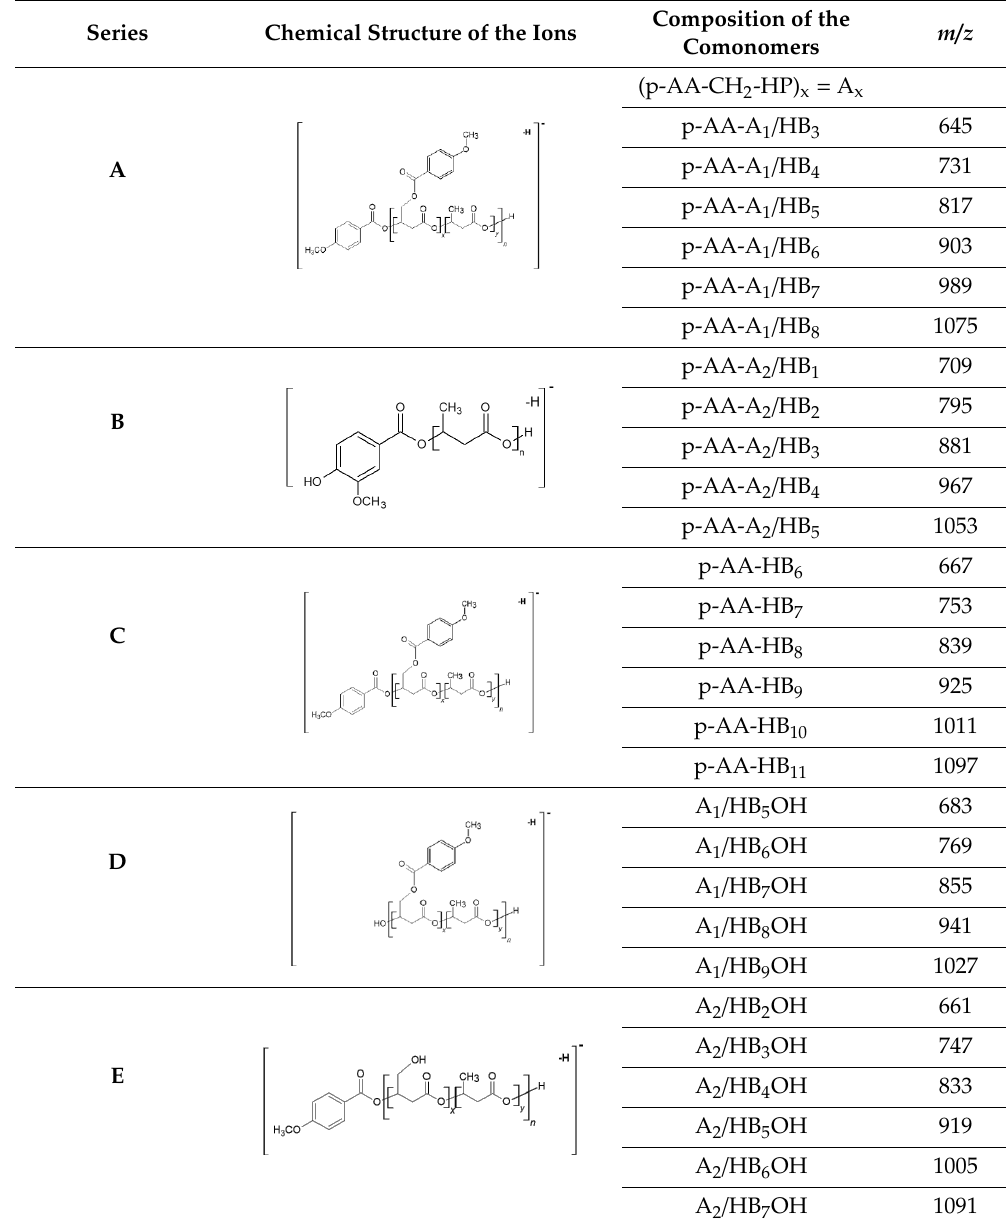
Table 2. Structural assignments of ions present in the enlarged region ( m / z 600–1100) of the electrospray mass spectrometry (ESI-MS) of the degradation products of [(p-AA-CH 2 -HP) x -co-(HB) y ]. Spectra depicted in Figures 3 and